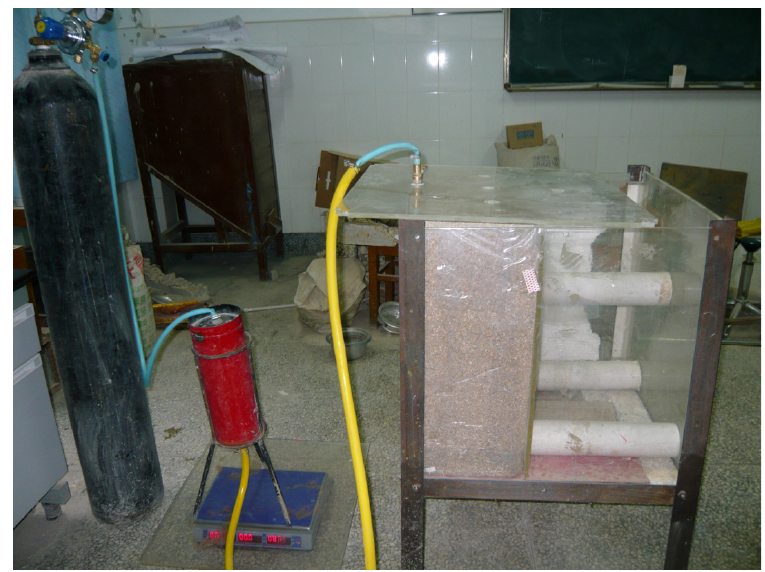
Figure 4 . Photograph of the grouting experimental device. Figure 4. Photograph of the grouting experimental